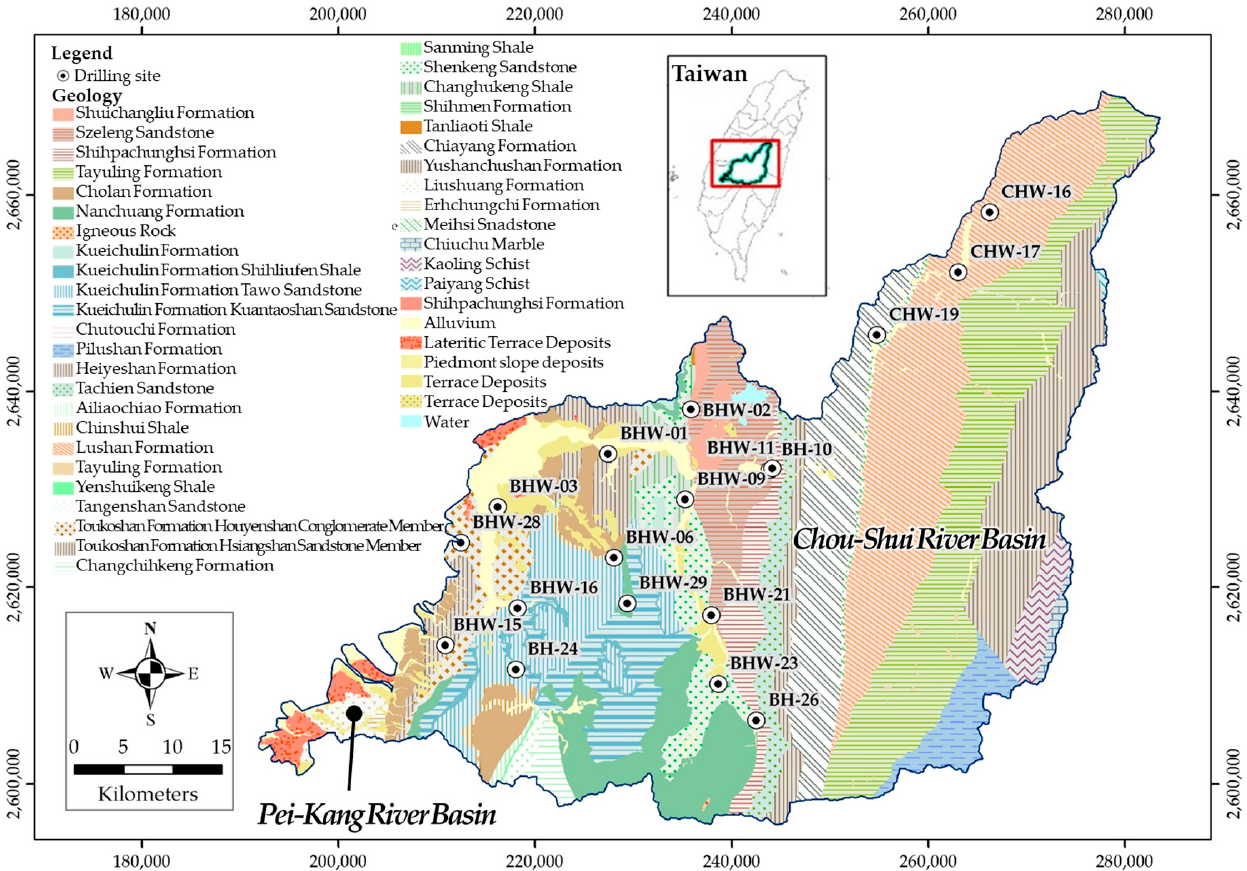
Figure 1. Location map of the study area and the 40 groundwater monitoring wells.